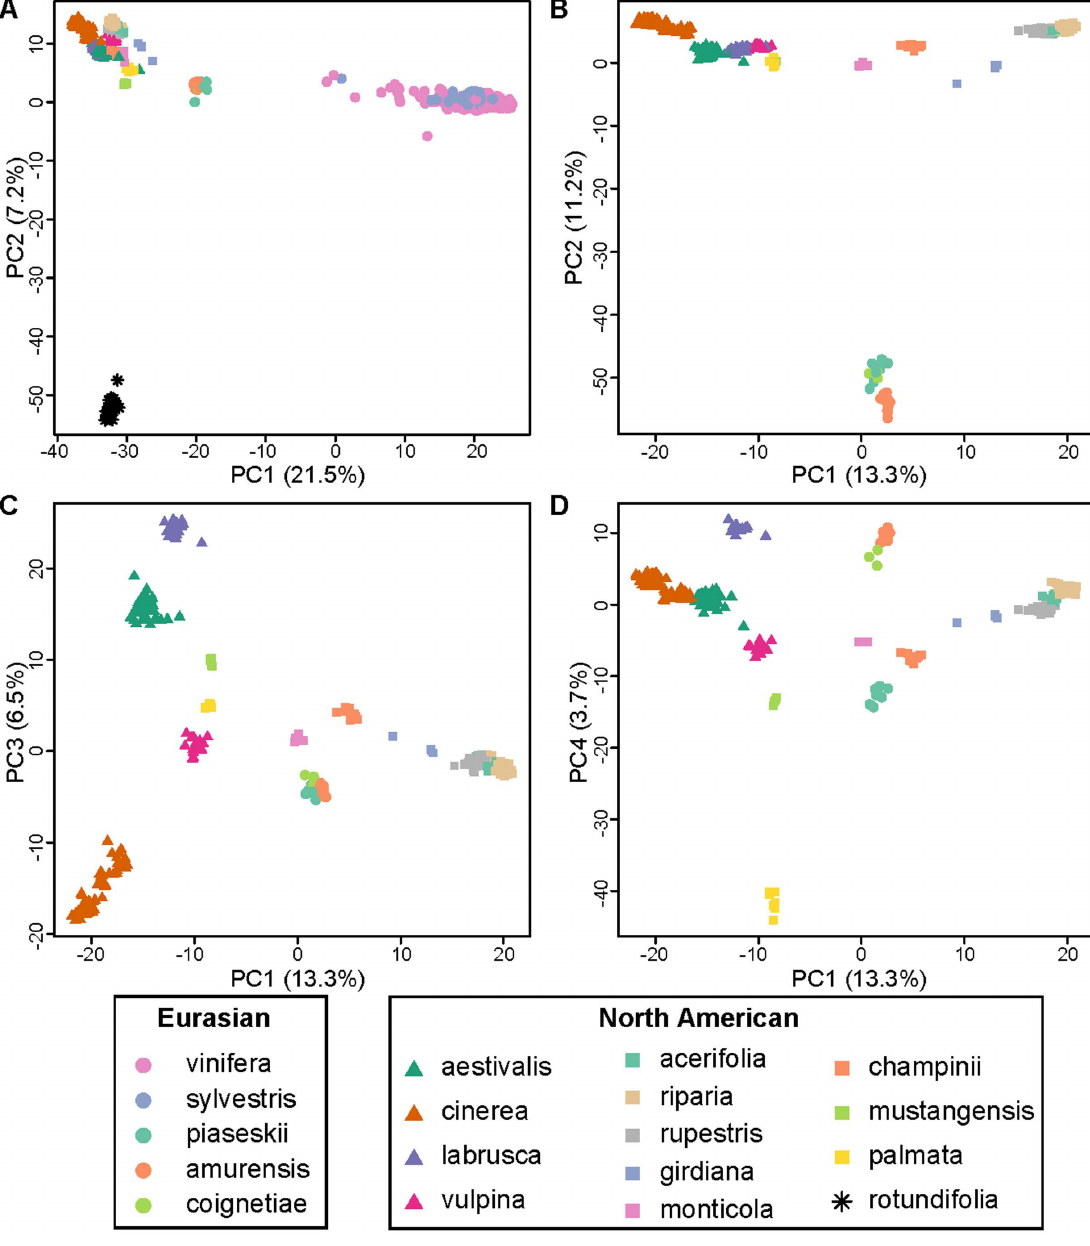
Figure 1. Principal components analysis (PCA) of 1030 Vitis samples using 3231 SNPs. The proportion of the variance explained is found within parentheses on each axis. A) PCA with all samples included. PC1 clearly separates vinifera and sylvestris from the other wild Vitis species while PC2 separates rotundifolia from all others. B–D) PCA with rotundifolia , sylvestris and vinifera removed. Examining the distances between individual samples in PC space confirms that the curated sample set used in the present study does not likely suffer from mislabeling or curation error that would lead to false phylogenetic inference.